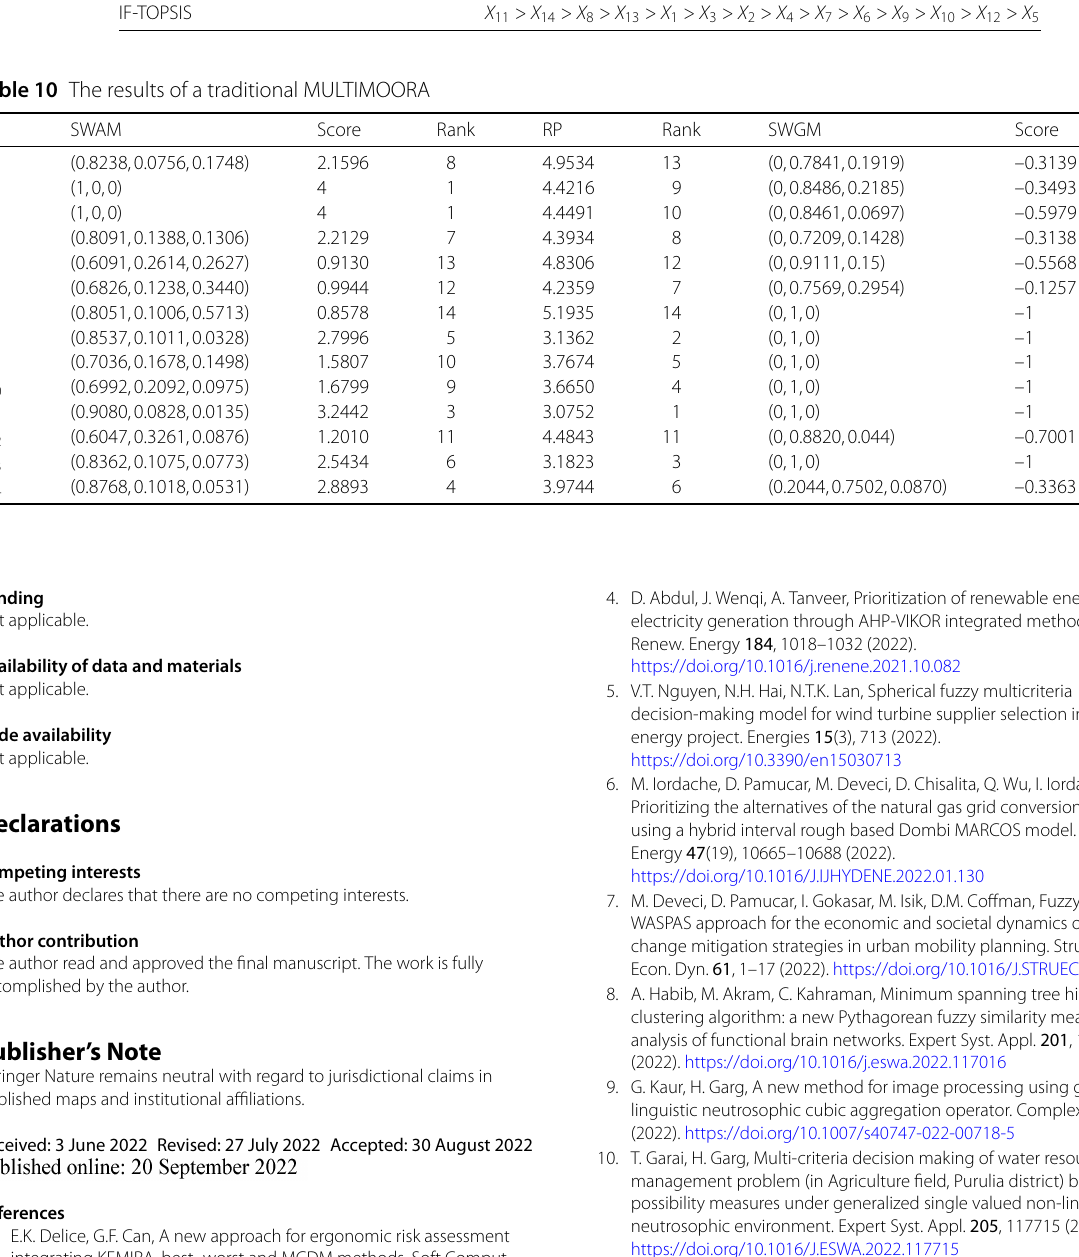
Table 9 Ranking using different methods for ESTs Method Rank Proposed SF-MULTIMOORA (Theoretical reference points)